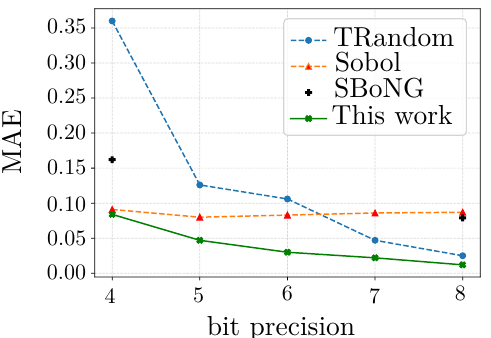
Figure 10. MAE for the best outcomes of each method employing the